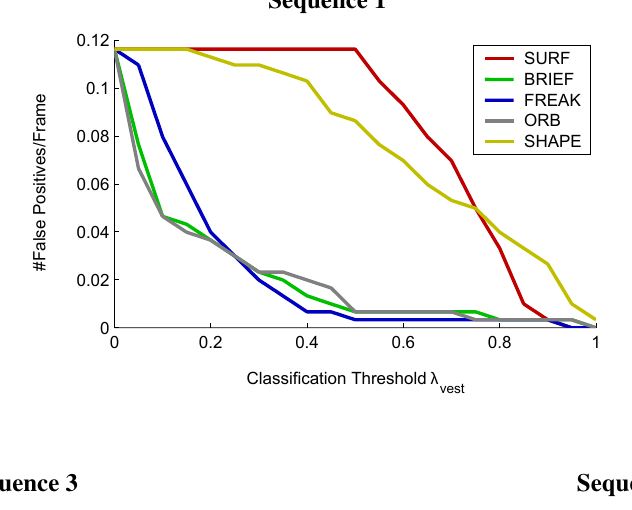
Figure 13. Number of false alarms per frame depending on the feature descriptor and the classification threshold λ in use. No graph is shown for sequence 2, as it does not vest contain any reflectors other than the ones on the safety garments, leading to zero false alarms independent of the classification threshold.